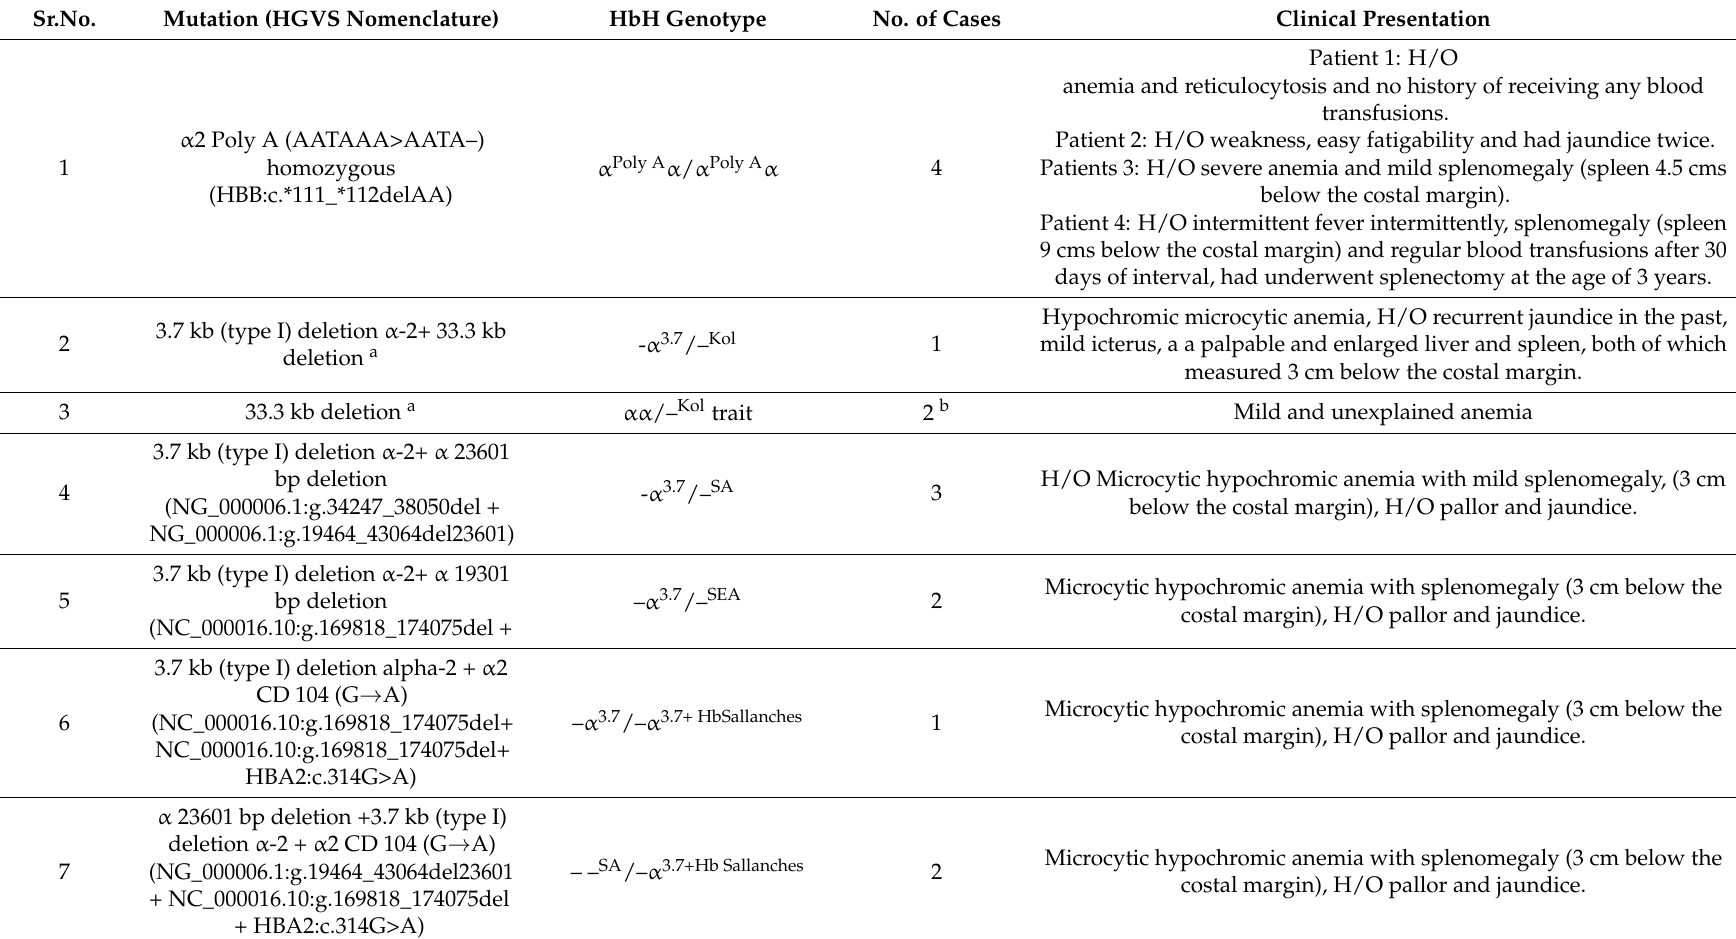
Table 1. Distribution of Hb H disease cases along with their mutations and clinical